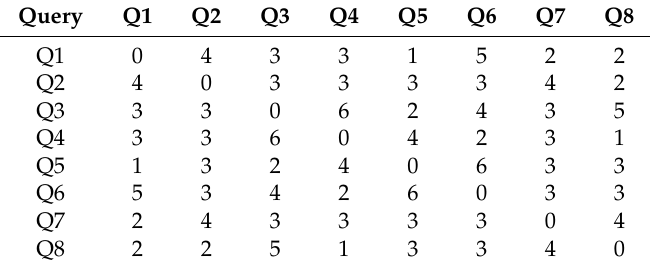
Table 6. Query difference matrix (QDM).